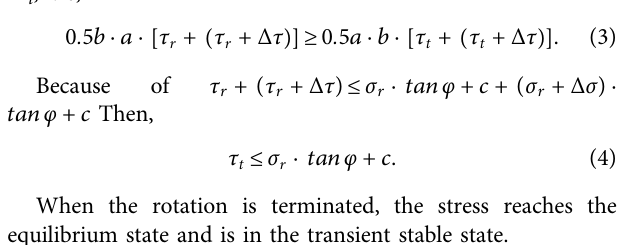
FIGURE 1 | Kinematic conditions for fl exural slip preceding toppling: (A) directionsofstressandslipdirectionsinrockslope; (B) conditionforinterlayer